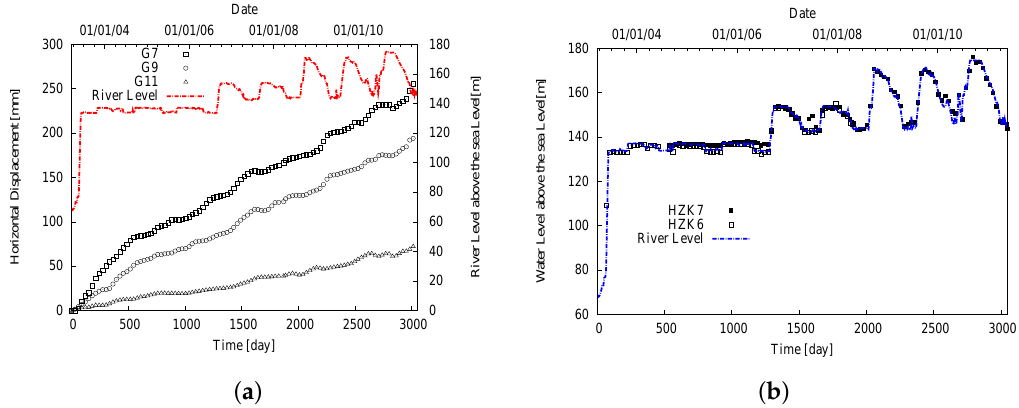
Figure 2. ( a ) Measured horizontal displacements after the impoundment of the Three Gorges project. ( b ) Groundwater level monitoring and river level